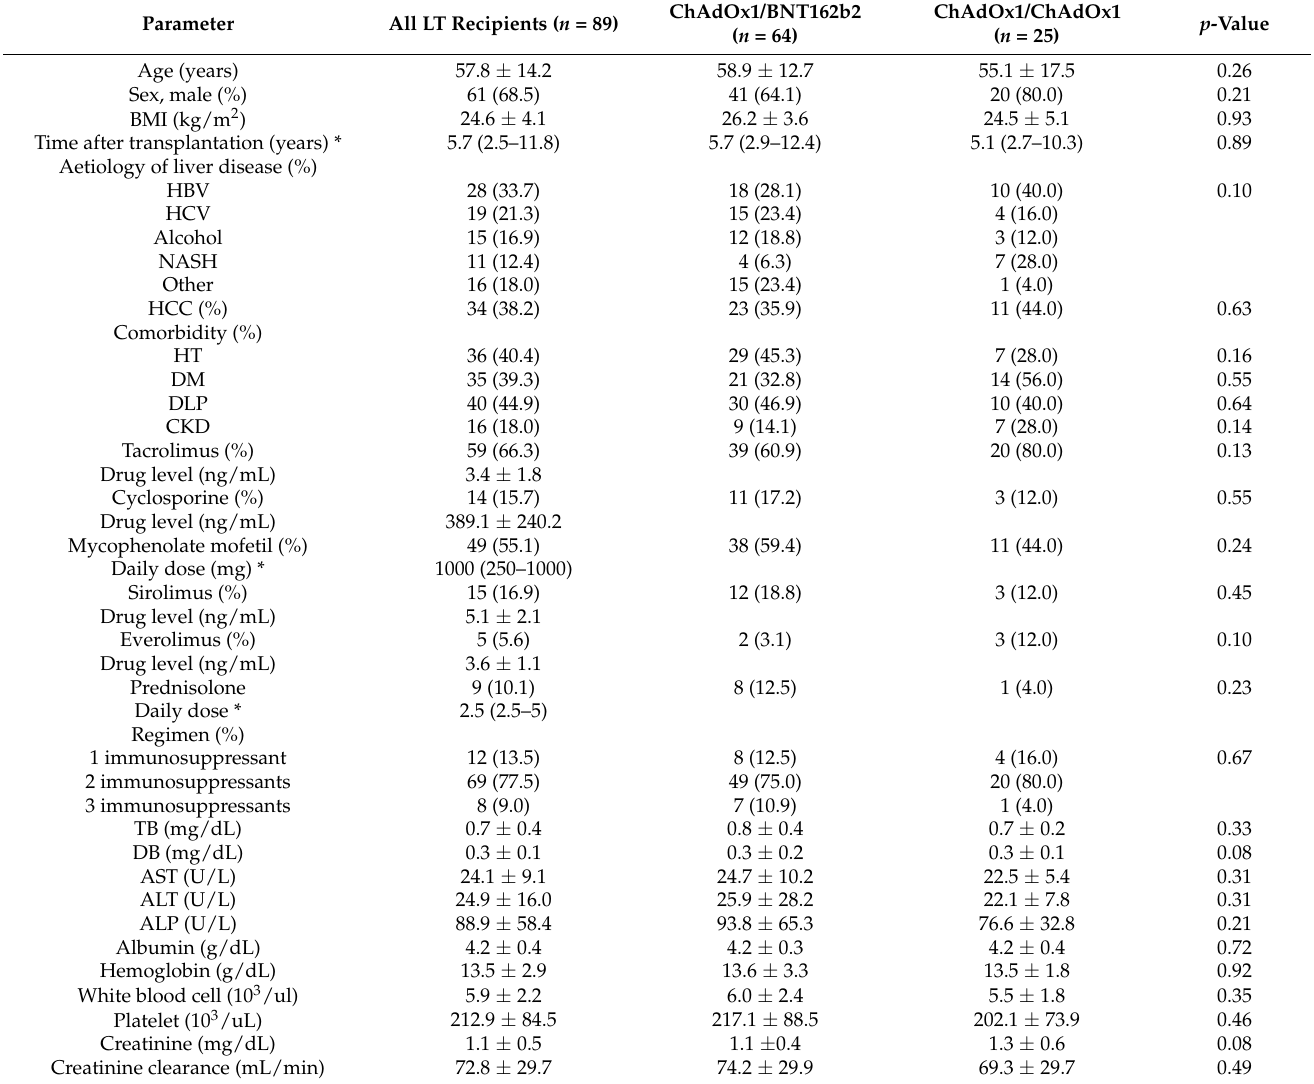
Table 1. Baseline characteristics for LT recipients and comparison of LT recipients with heterologous and homologous prime-boost